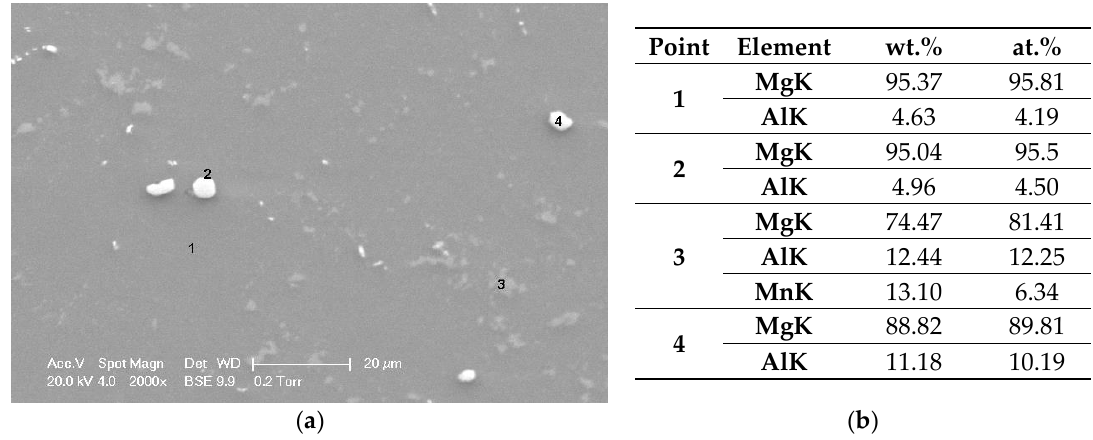
Figure 7. Initial state microstructure of investigated alloy ( a ) and corresponding pointwise chemical composition analysis ( b ).